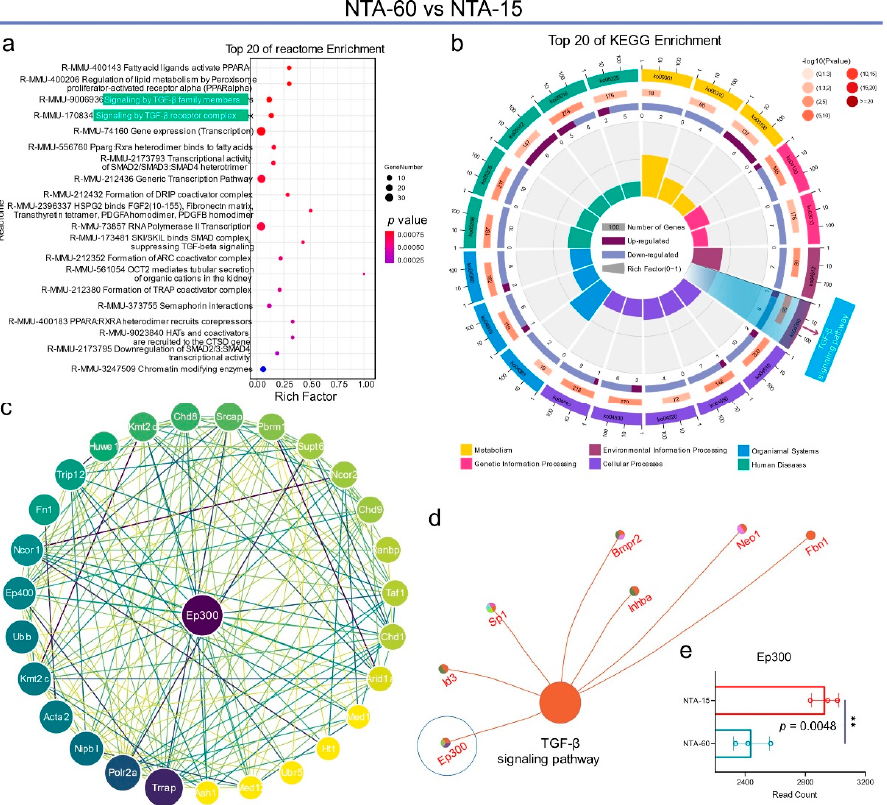
Figure 6. Analysis of differential genes within NTA-60 vs. NTA-15. ( a ) KEGG pathway enrichment analysis of NTA-60 vs. NTA-15. ( b ) Circular enrichment of KEGG pathways. ( c ) Protein interaction analysis of the differentially expressed genes. ( d ) Differential genes in the TGF- β signaling pathway. ( e ) The gene expression profile of Ep300. ** p < 0.01.